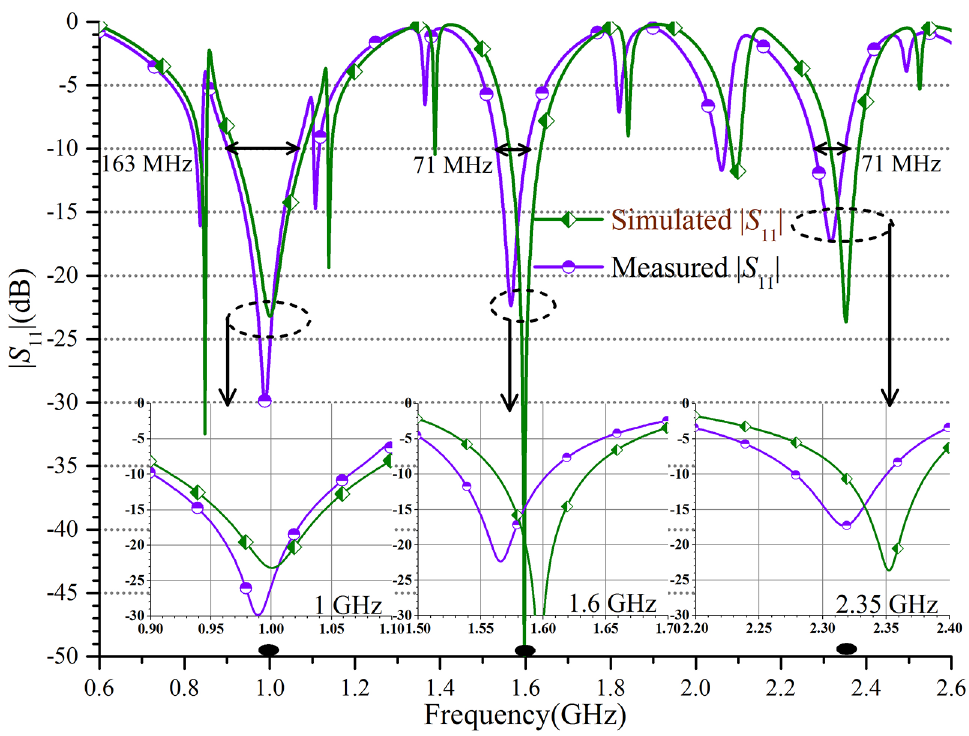
Fig 6. The TTPD with the complete tri-band performance. The simulatedand measuredinput reflection coefficient | S 11 | and the three sub-graphsextracted at 1 GHz, 1.6 GHz, and 2.35 GHz are given. https://doi.org/10.1371/journal.pone.0178956.g006 PLOS ONE | https://doi.org/10.1371/journal.pone.0178956 June 6,